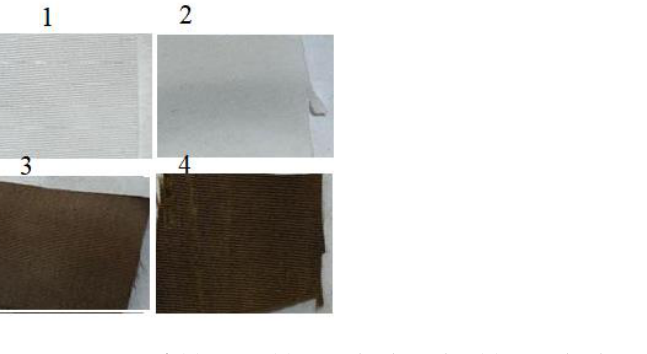
Figure 2. Images of ( 1 ) PET, ( 2 ) PET hydrazide, ( 3 ) PET hydrazide-AgNP-PDA, and ( 4 ) PET hydra- zide-AgNP.